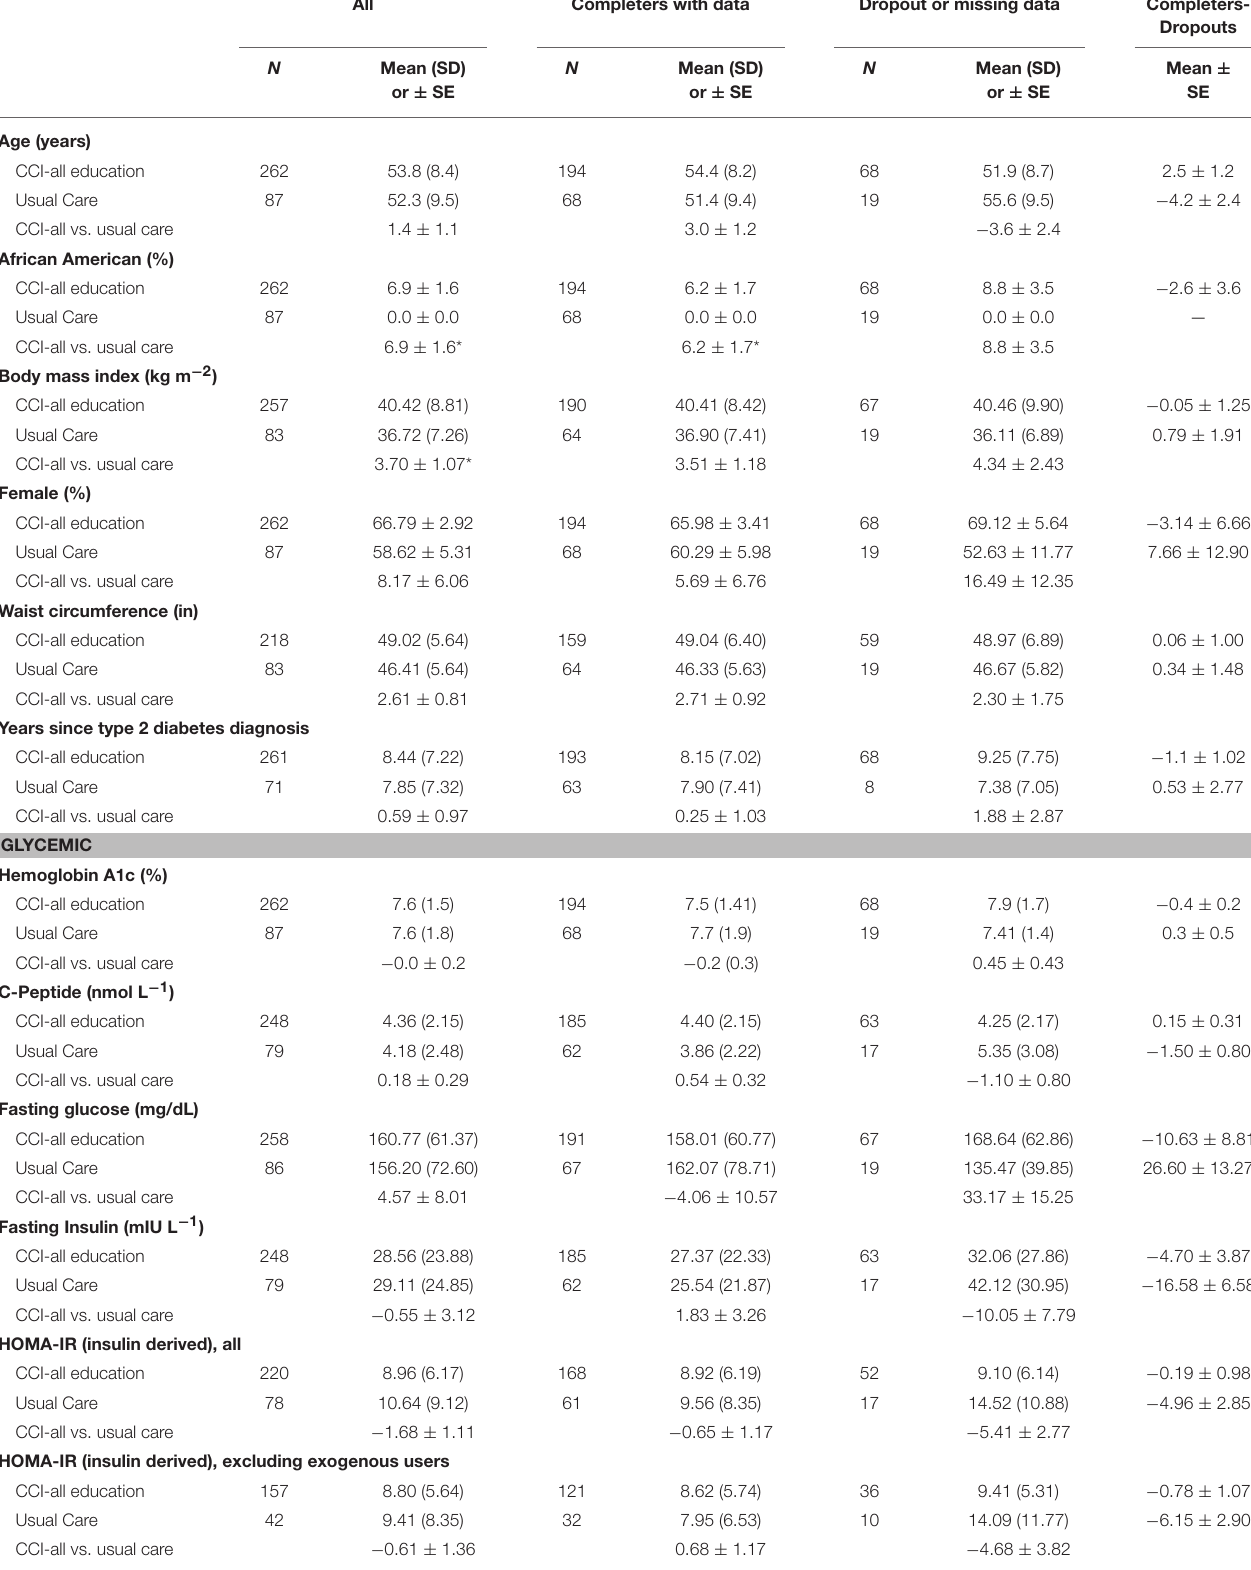
TABLE 1 | Baseline